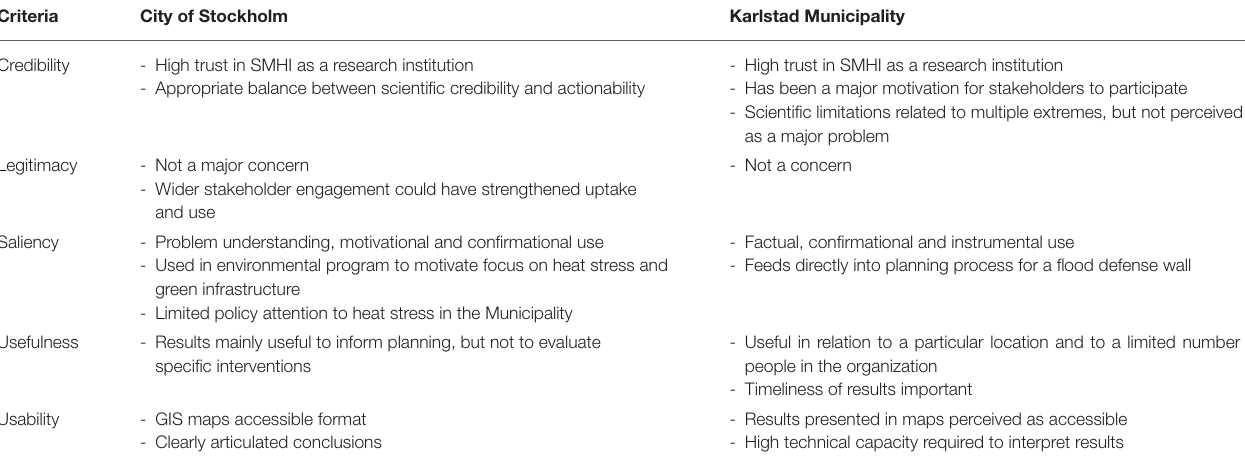
TABLE 2 | Results overview: achievement of adaptation knowledge quality criteria in case studies.